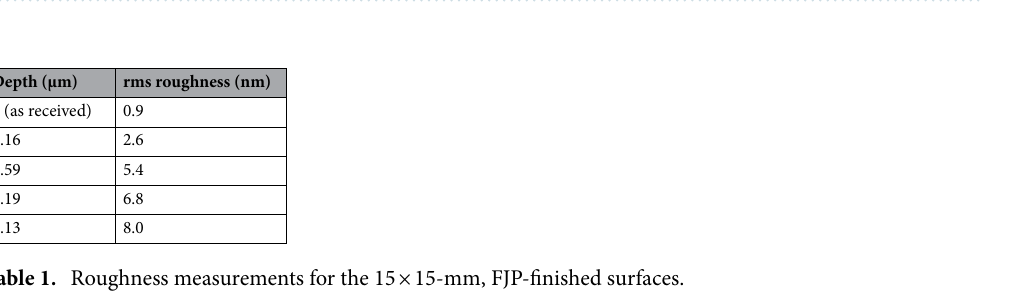
Figure 3. Surface profile of the X-cut KDP substrate fabricated for this study: ( a ) 0.16 μm, ( b ) 1.59 μm, ( c ) 4.19 μm, and ( d ) 5.13 μm.